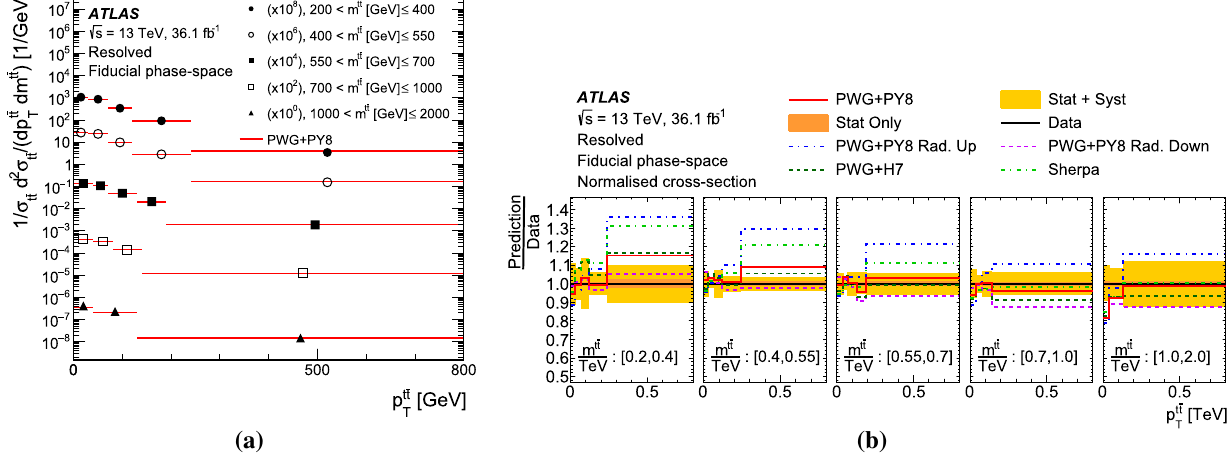
Fig. 27 a Particle-levelnormaliseddifferentialcross-sectionasafunc- tion of p t ¯ t in bins of m t ¯ t in the resolved topology compared with the T prediction obtained with the Powheg + Pythia8 MC generator. Data